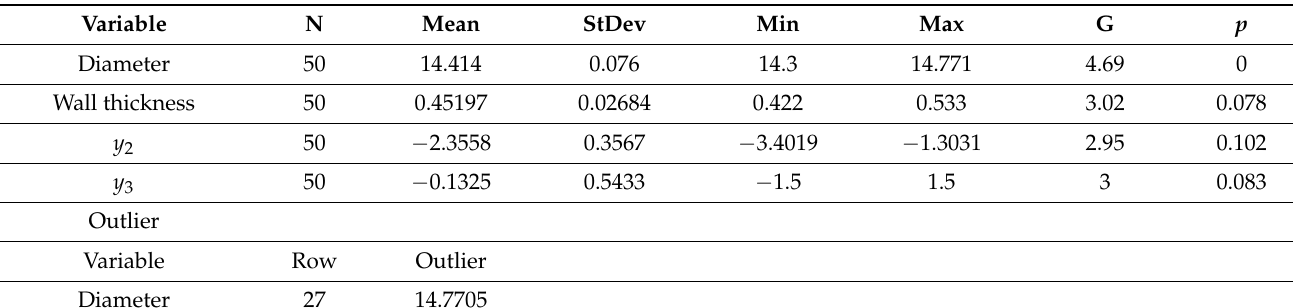
Table 9. Grubbs’ test of